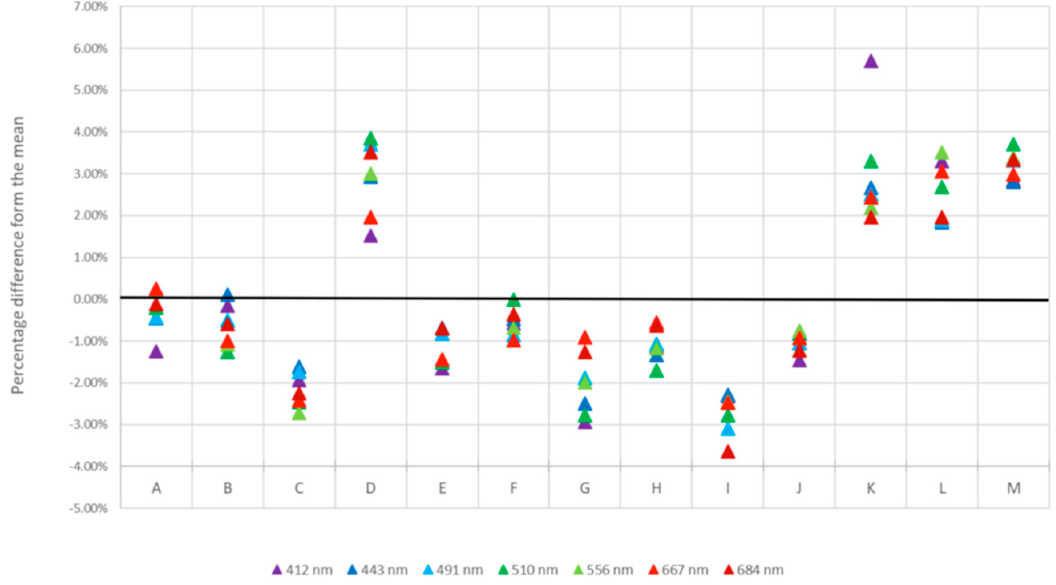
Figure 7. Comparison between radiance sources of participant OCR calibration laboratories (A–M) showing mean coefficient percentage difference across all distances. Reproduced with permission from [43].